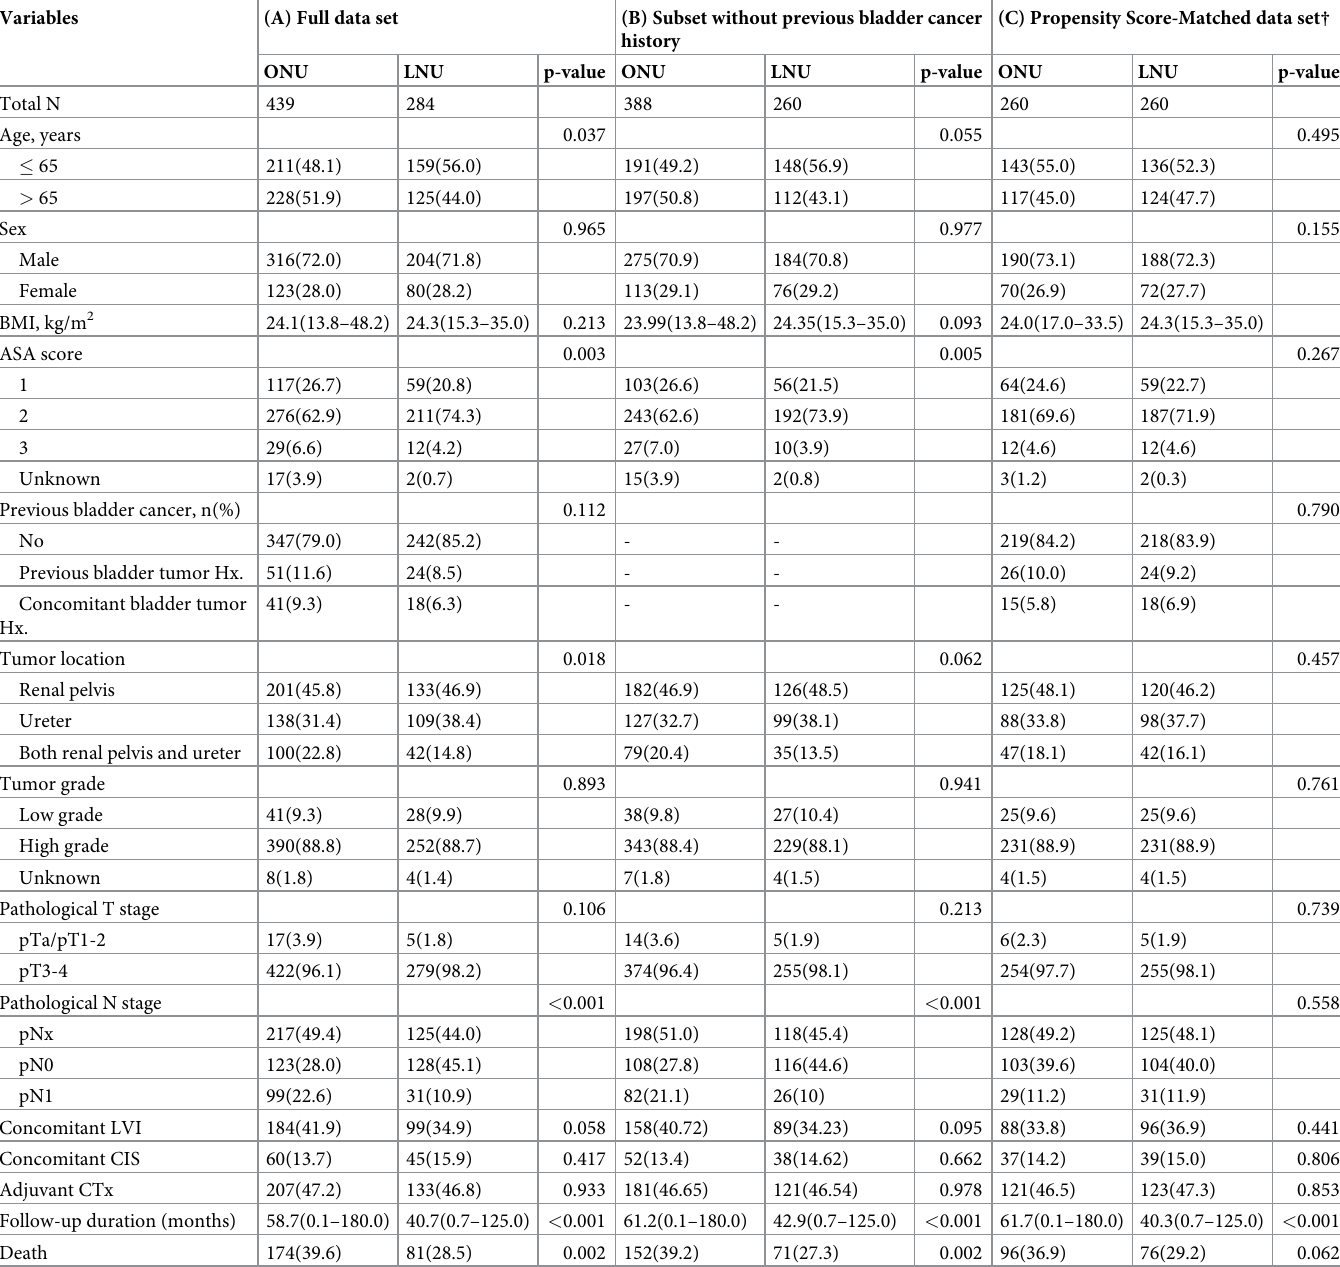
Table 1. Comparison of baseline characteristics between open and laparoscopic radical nephroureterectomy in upper urinary tract urothelial carcinoma (A) among all patients (N = 723), (B) patients without previous history of bladder cancer only, and (C) after propensity-score matching.